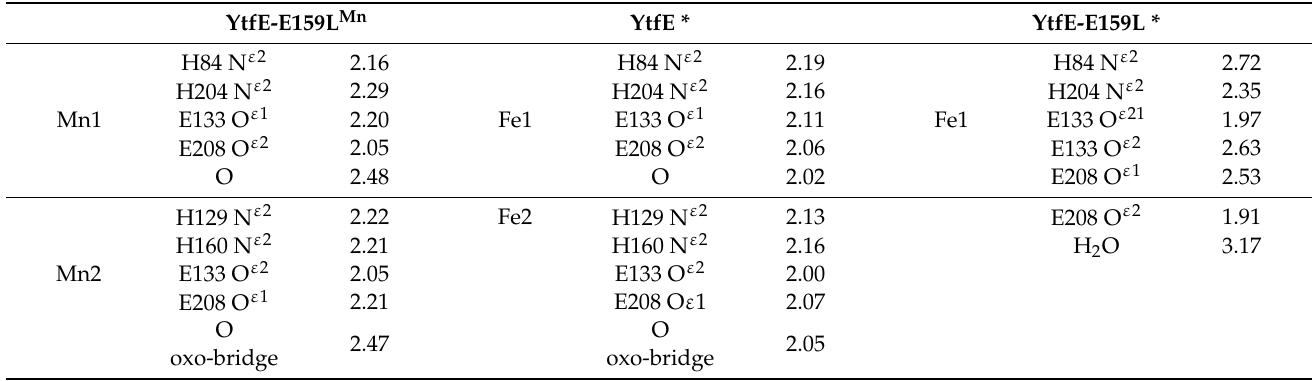
Figure 3. Structures of E. coli YtfE- E159L/YtfE-159L Mn and YtfE Mn . ( A )—Superposition of YtfE-E159L (yellow cartoon with the only iron atom shown as a black sphere) with YtfE-E159L Mn (cyan cartoon with the metal sites occupied by Mn atoms represented as violet spheres). Figure shows that residues L159 and H129 have their side-chain positions shifted when Mn occupies the center. ( B , C )—Anomalous difference maps of wild type YtfE co-crystallized with an excess of Mn. View of the anomalous difference map peaks drawn at the 8 σ level in the di-metal site calculated from anomalous differences obtained at the Mn K-edge (1.8917 Å) (( B ), purple mesh) and at the Fe K-edge (1.7313 Å) (( C ), orange mesh). Ligand residues are represented as sticks and the monomer is shown in cartoon representation, colored in rainbow colors from blue (N-terminal) to red (C-terminal). Table 2. Distances (Å) between the atoms of coordinating ligands relative to the di-metal site in YtfE-E159L Mn mutant, and comparison with equivalent distances observed in di-iron containing YtfE wild type and E159L